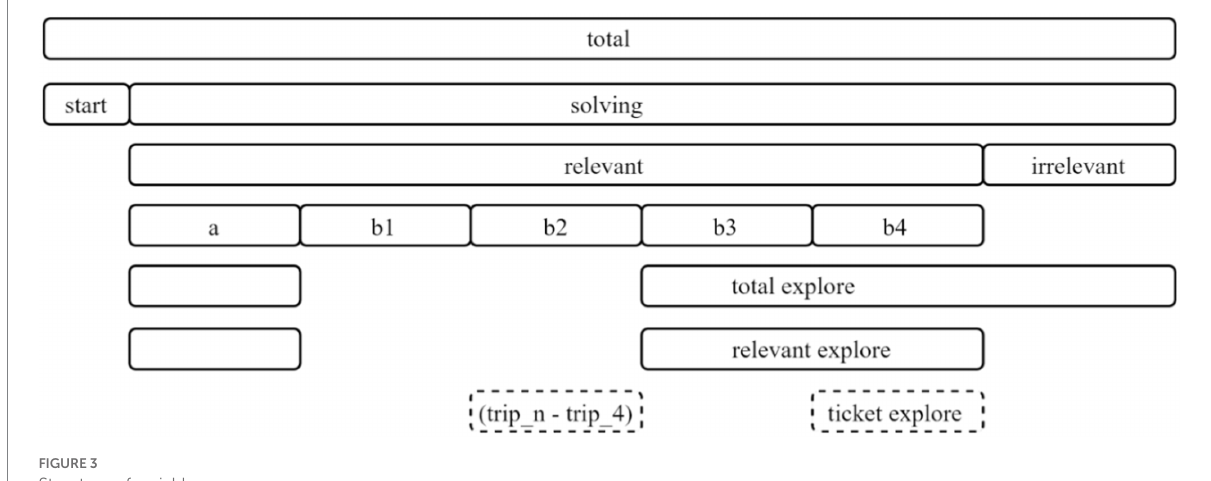
FIGURE 3 Structure of variables.